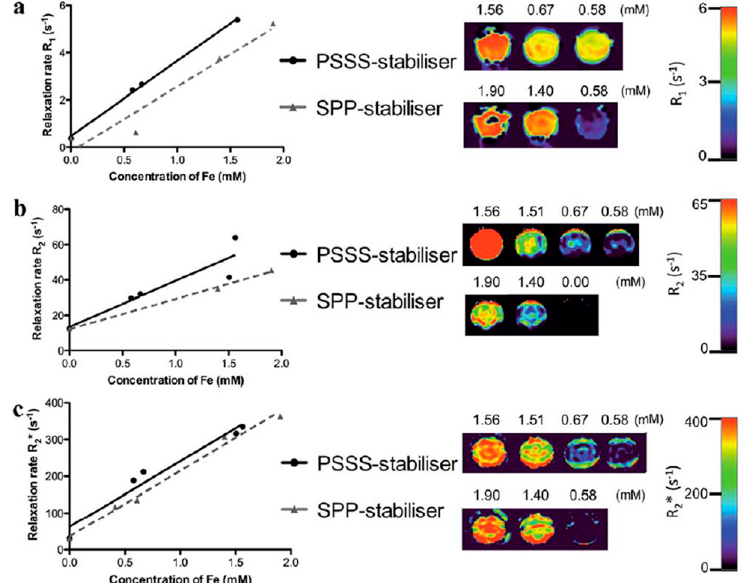
Figure 8. Relaxivities of the Fe 3 O 4 -poly(sodium 4-styrenesulfonate) (PSSS) (straight line) and Fe 3 O 4 -sodium polyphosphate (SPP) (dashed line) nanocomposites measured at 3 T and 20 °C. Scatter plots show correlations between measured ( a ) R 1 , ( b ) R 2 , and ( c ) R* 2 values of the nanocomposites and iron concentrations measured using inductively coupled plasma mass spectrometry (ICP-MS). The relaxation rates (R 1 , R 2 , and R* 2 ) were determined at 3 T using T 1 , T 2 , and T* 2 mapping sequences, respectively, and aqueous solutions between 0 and 2 mM of the contrast agents. Pearson’s correlation coefficient values ranged from 0.92 to 0.99. Phantom MRI images of the formulations show R 1 , R 2 , and R* 2 maps in color scale. R 1 , R 2 and R* 2 values increase with increasing concentrations of contrast agents (highest concentration on the left). Reproduced with permission from Reference [150].